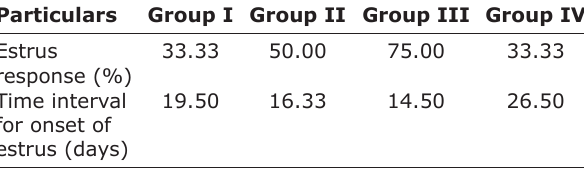
Table-2: Effect of herbal supplementation on estrus response and mean time interval recorded for onset of estrus in different groups.